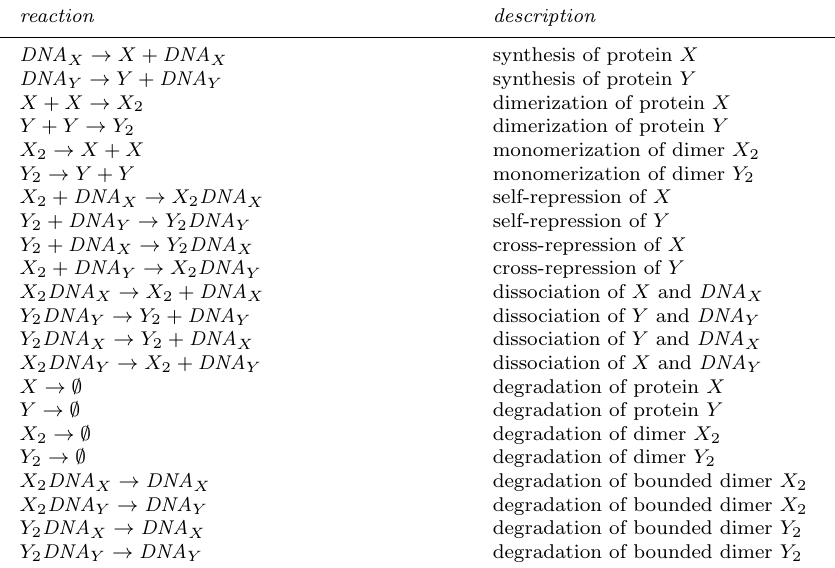
Table 2. Observed chemical reactions that directly affect the dynamics of the analyzed system